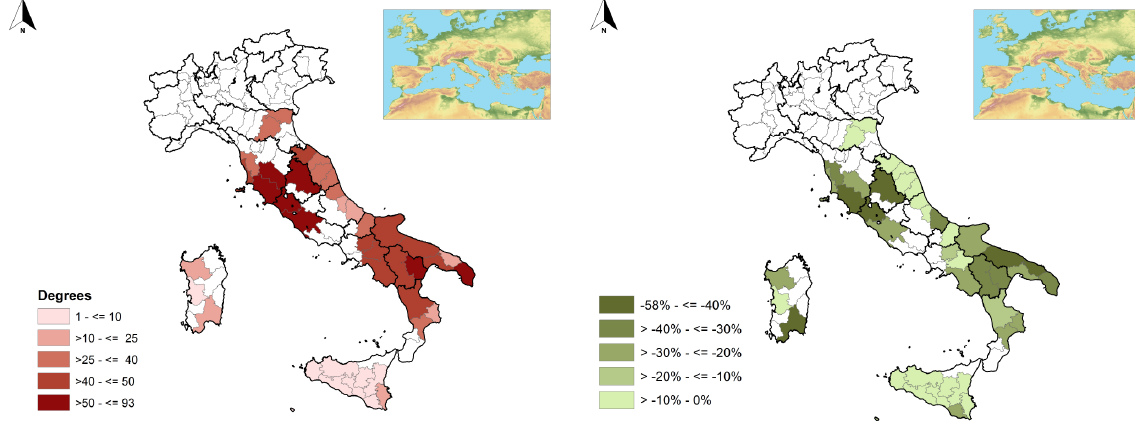
Figure 5. Left panel: intensity of the early heat waves that occurred in 2003, values in degrees. Right panel: yield anomalies in 2003.